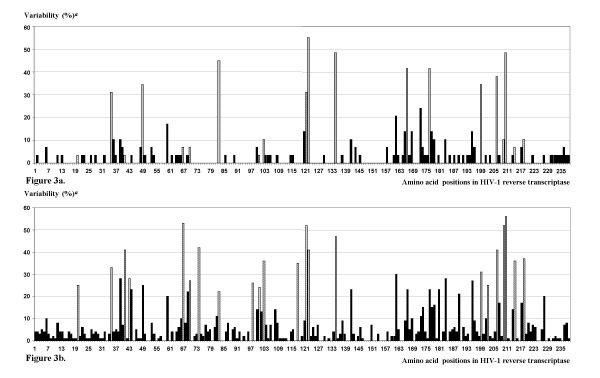
Amino acid variability at each site of HIV-1 reverse transcriptase for untreated individuals (n = 29, figure 3a) and patients treated with nucleoside reverse transcriptase inhibitor-containing regimen (n = 100, figure 3b). Gray rods indicate positions where variability exceeded 30%. Hachured rods indicate positions where differences between variability in treated and untreated patients exceeded 20%. a Variability was considered as the percentage of sequences that harbored (at a given position) an amino acid that was not the most frequently found in the studied set of sequences.